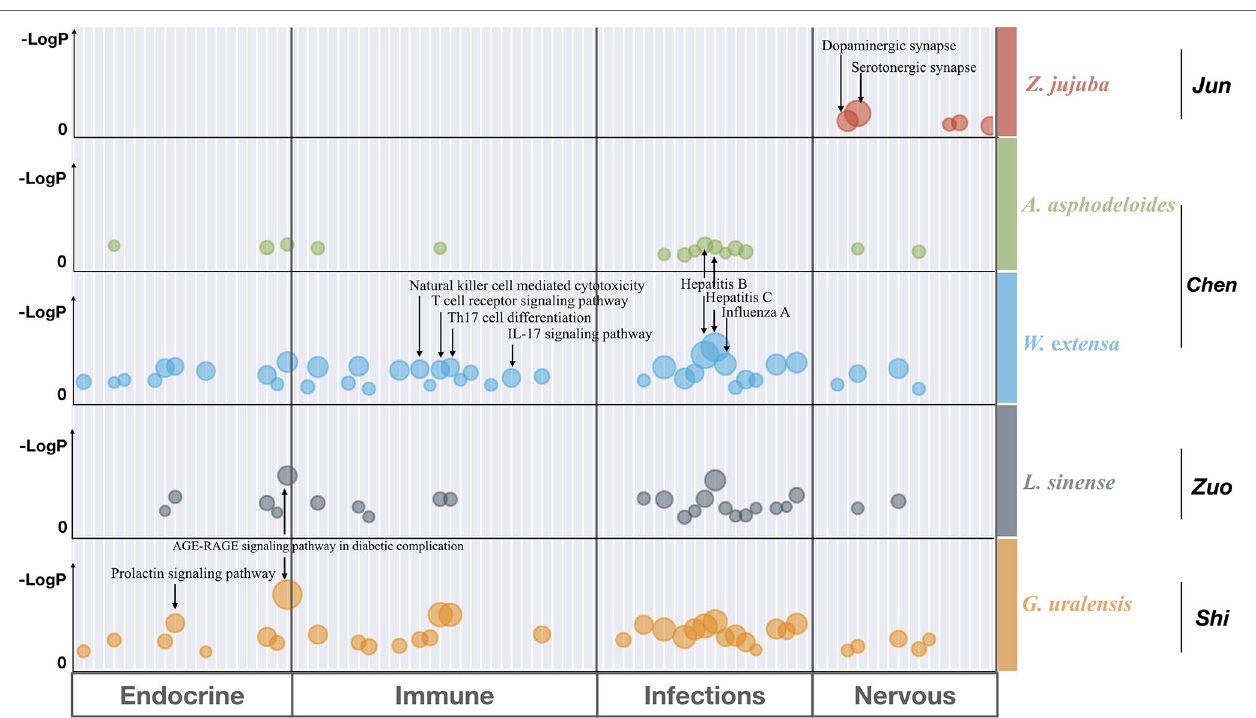
FIGURE 3 | Bubble graph for significantly enriched pathway terms from KEGG by Metascape. Each bubble represents one KEGG pathway term. The size of the bubble correlates with the relative ratio of targets hitting each pathway over the total targets, with larger bubbles indicating the more enriched terms. The LogP shows the statistical significance of p -values, with larger and higher numbers indicating the more significant ones. And only those functional terms were retained with both −Log( p -value) > 5 and enrichment ratio > 5%. The detailed statistical data are shown in Table S2